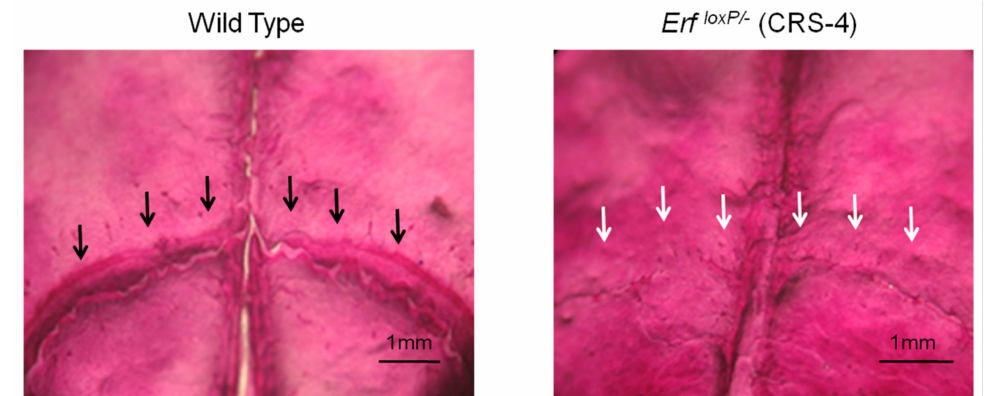
Figure 15. OM image ( × 1 magnification) of a histological examination of the coronal sutures of P65 mouse calvaria stained with Alizarin Red and Alcian Blue. Black arrows indicate the position of the open suture in wild-type animals and white arrows indicate the position of the ossified suture in the Erf loxP/ − (CRS-4) craniosynostosis animals.